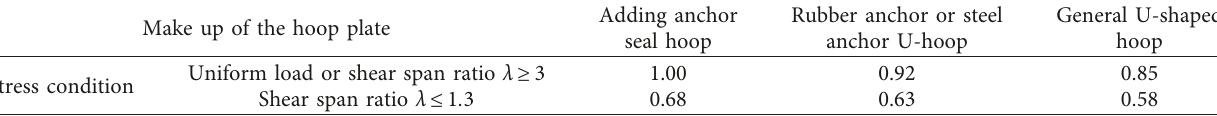
Table 1: Value of the shear strength reduction factor ψ